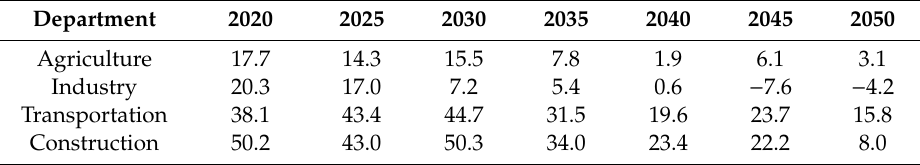
Figure 4. Primary energy consumption of the power industry.